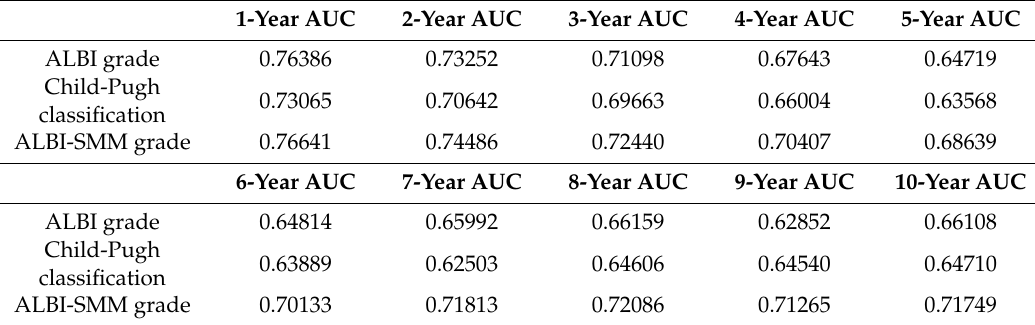
Table 3. Area under the receiver operating characteristic curve (AUC) for each time point in the ALBI grade, the Child-Pugh classification and the ALBI-SMM